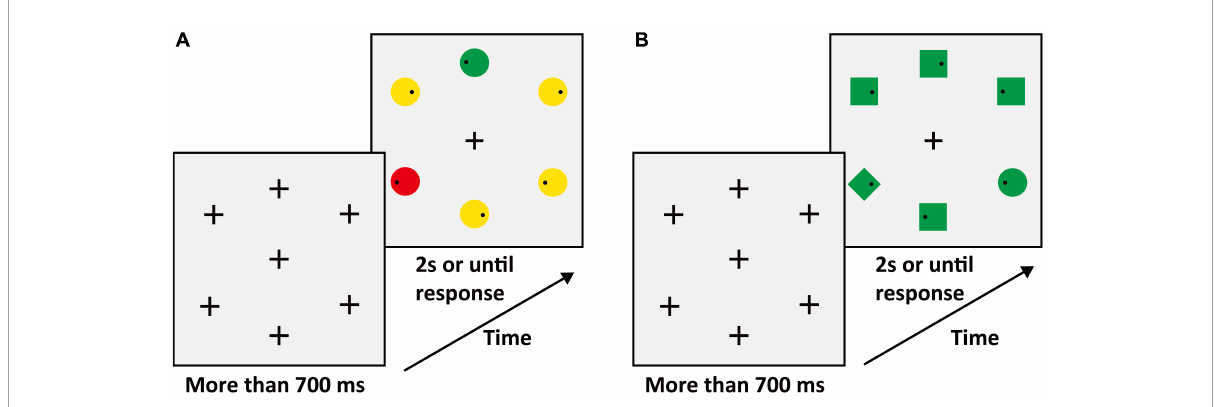
FIGURE4 (A) Schematic procedure of the color search task (e.g., target: green circle). (B) Schematic procedure of the shape search task (e.g., target: green